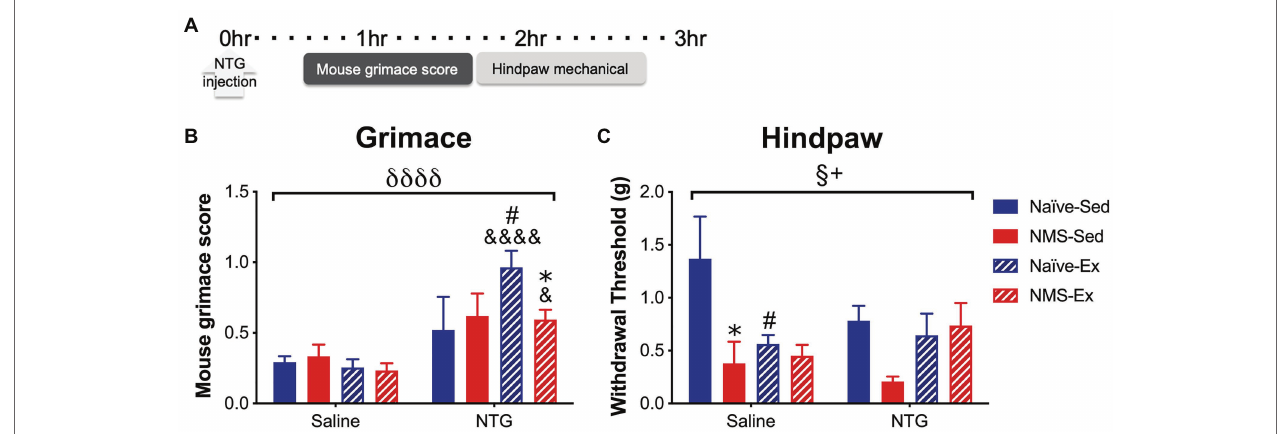
FIGURE 5 | Mouse grimace score and hindpaw mechanical withdrawal threshold was measured in naïve and NMS mice that were Sed or Ex following an intraperitoneal injection of saline or NTG. (A) MGS was measured every 5 min over 1 h, beginning 30 min after NTG injection. Hindpaw mechanical thresholds were measured immediately afterward. (B) A significant overall effect of NTG was observed on MGS. Naïve-Ex-NTG mice had a significantly higher MGS then naïve-Sed-NTG and naïve-Sed-Saline mice. NMS-Ex-NTG mice had a significantly lower MGS compared to naïve-Ex-NTG mice and a significantly higher MGS than NMS-Ex-Saline mice. (C) A significant